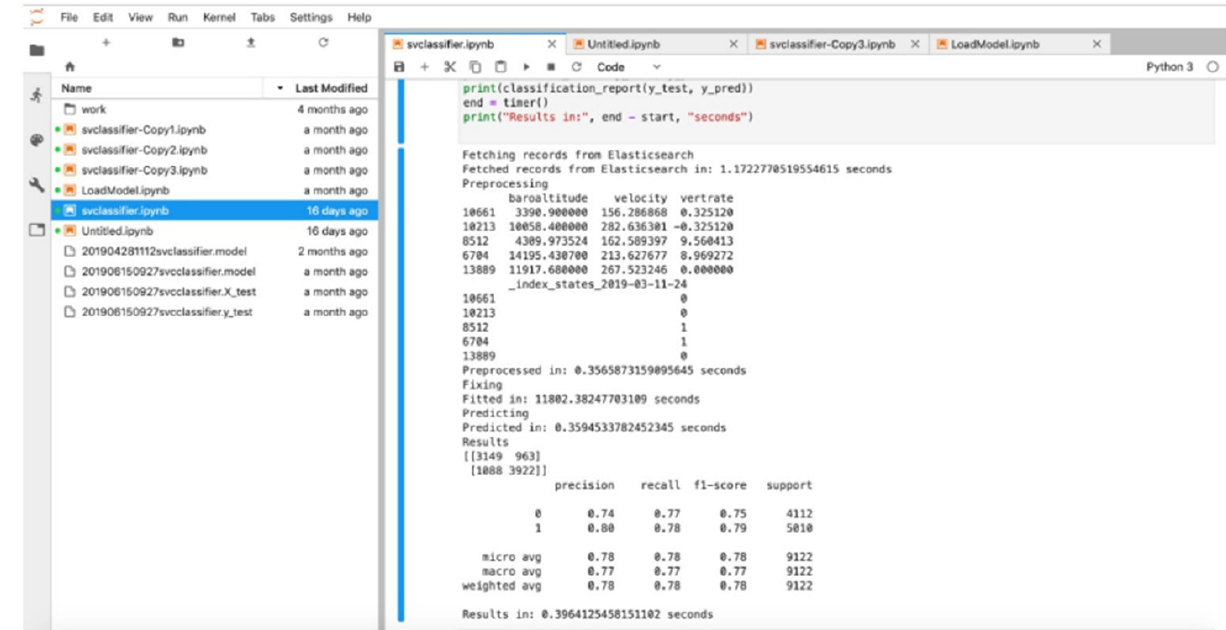
Figure 3. Elastic Kibana Visualizations of Statistics of OpenSky ADS-B Traffic.